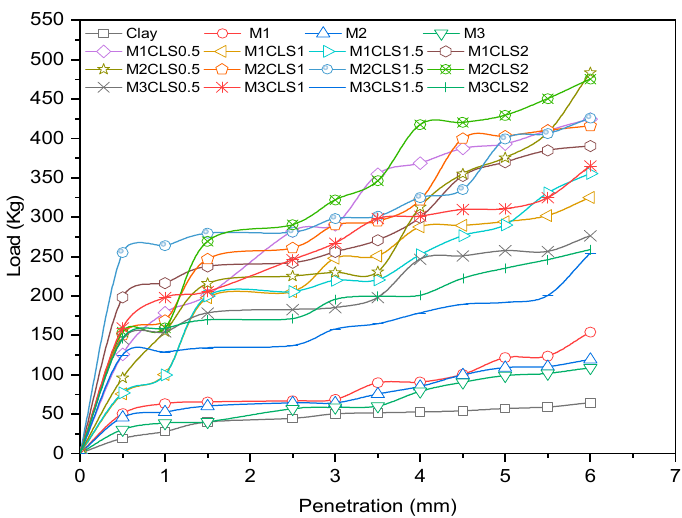
Figure 6. Load–penetration curves of clay-GS-CLS mix after 7 days of curing.